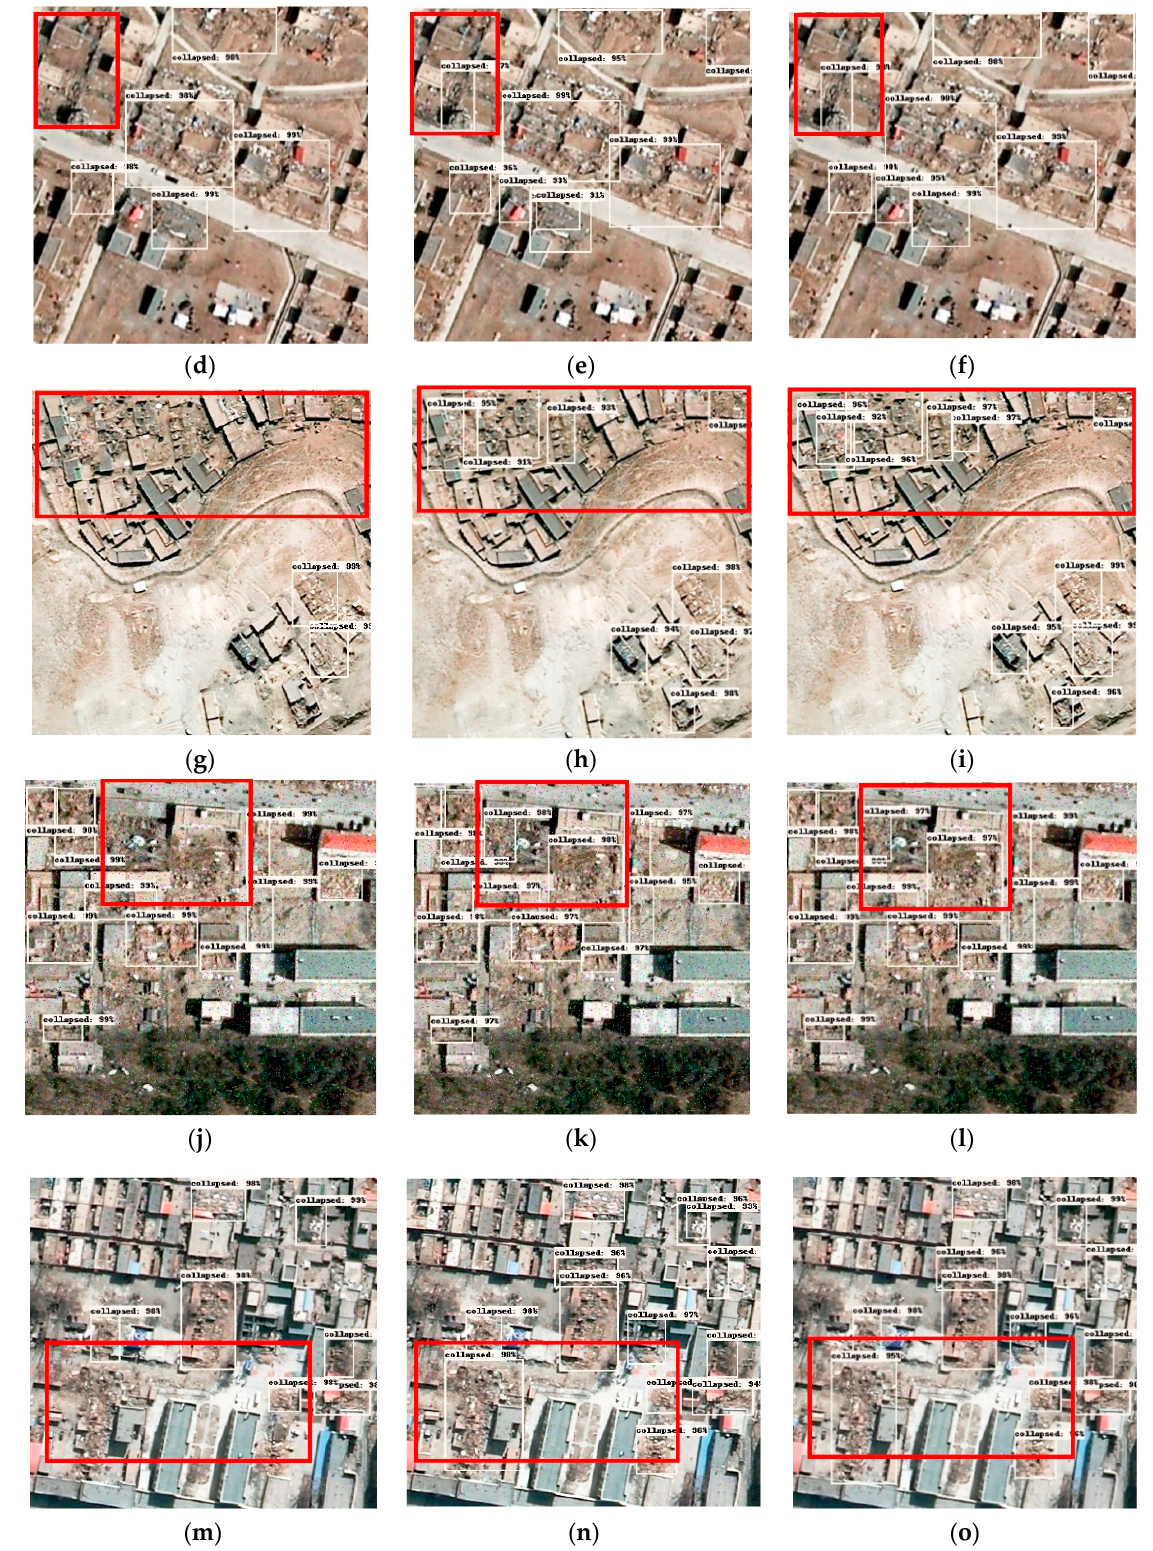
Figure 7. The results of the detection of collapsed buildings of the three models. From left column to right column are the detection results of YOLOv4 ( a , d , g , j , m ), YOLOv4+ResNext ( b , e , h , k , n ), and YOLOv4+ResNext-Focal+EIOU Loss ( c , f , i , l , o ) respectively.